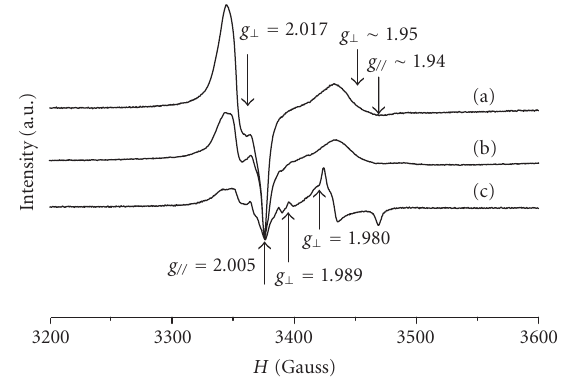
Figure 7: EPR spectra recorded at 10 K of (a) R100, (b) R70 TiO 2 sol-gel catalysts, and (c) commercial Degussa P25 after 30 minutes of in situ UV irradiation in helium atmosphere.